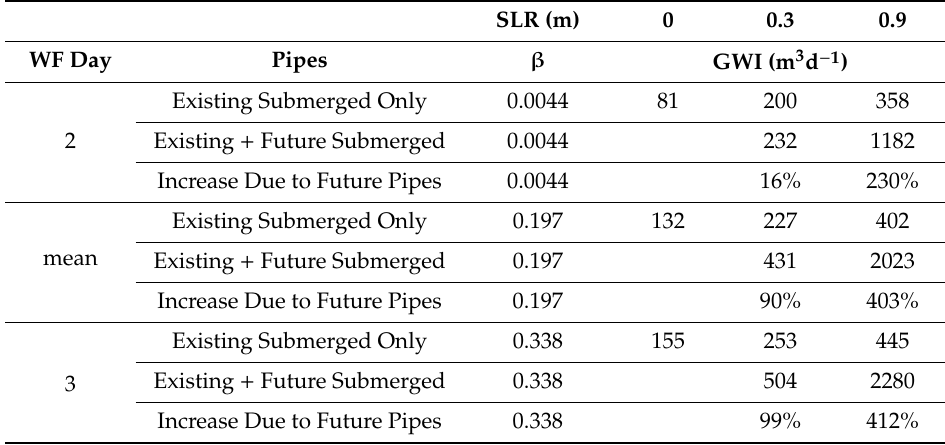
Table 4. Projected GWI flows for a range of e ff ective β and SLR of 0.3 to 0.9 m.